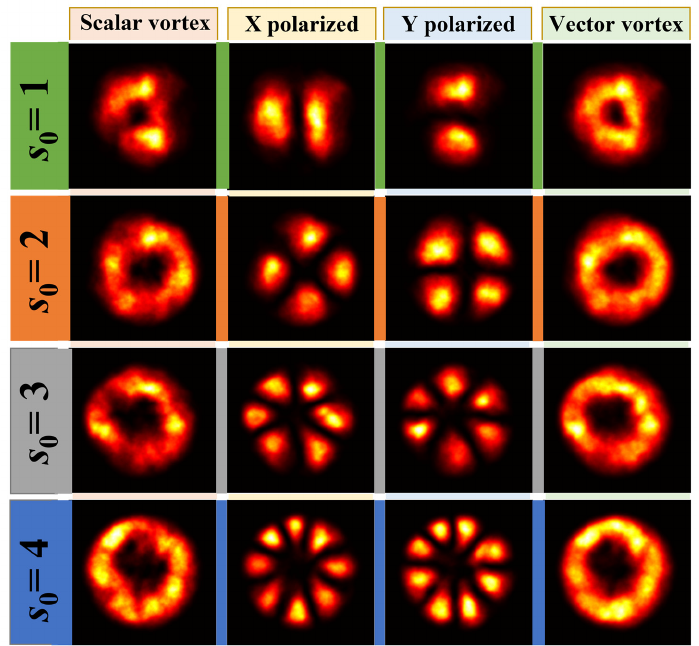
Figure 3. Comparison of intensity patterns between scalar and vector vortex beams (X-polarized component, Y-polarized component, and the ensemble) after propagation through the same atmospheric turbulence channel.